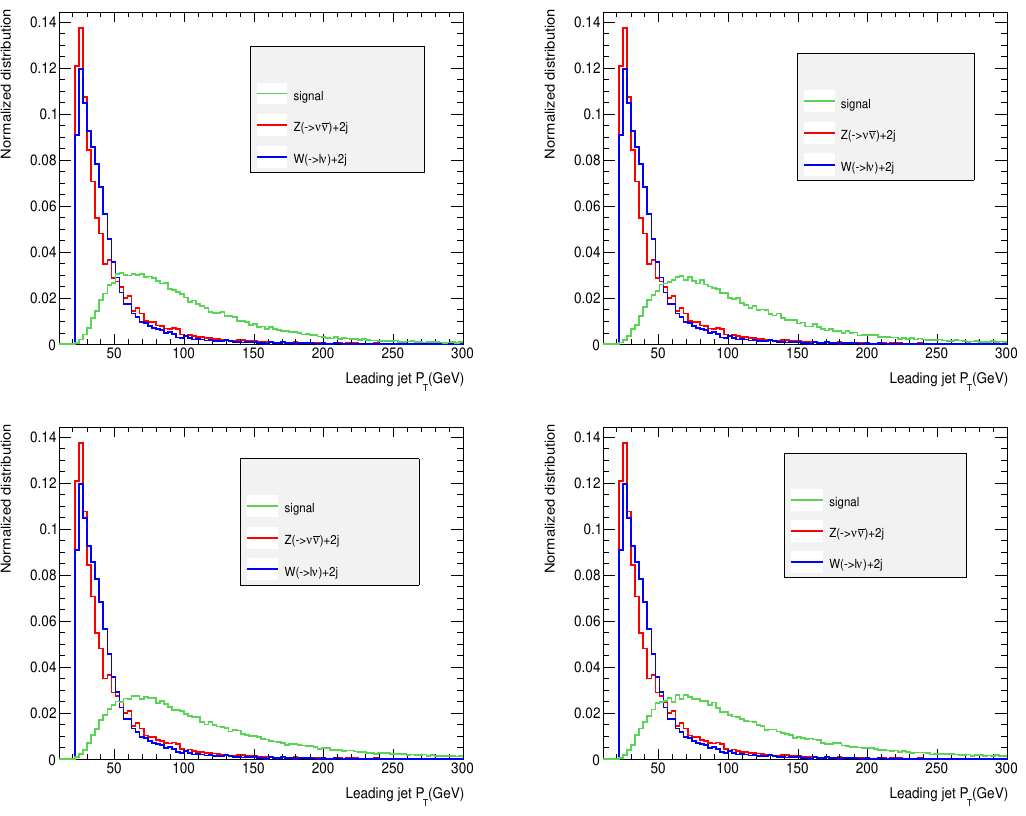
Figure 10 . P T distribution of the leading jet for vector boson fusion signal and background processes, Type I BP I(top left), Type I BP II(top right), Type II BP I(bottom left) and Type II BP II(bottom